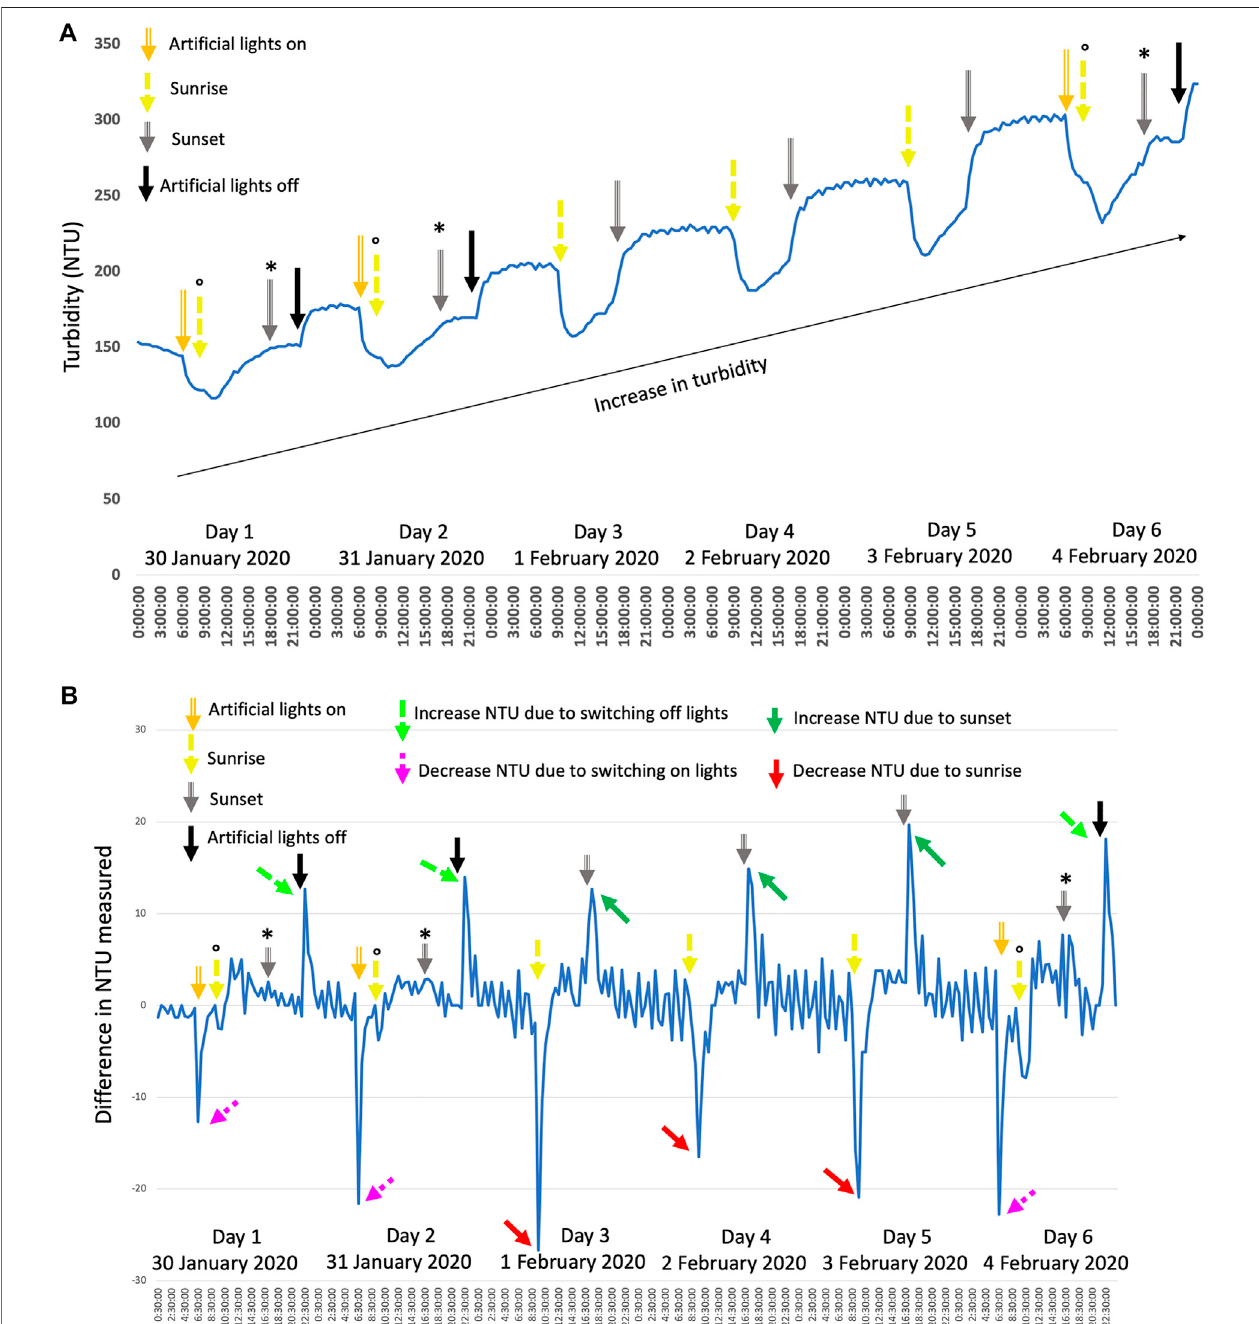
FIGURE 5 | (A) shows the typical growth pattern of C. typhlos observed over several days. A representative period during one of the winter periods is shown here witharti fi cial lights being used toextend theday. Arti fi cial lights were kept on between6.30 – 10.30 and 15.30 – 22.00,although slight variances were possible depending on the real sunset and sunrise times ofthe speci fi c days. (B) shows the difference in the NTU value calculated for every 30 min (NTUx+30min — NTUx) plotted over time. Arrows indicate speci fi c time points or substantial increases/decreases. The symbol ° denotes the arti fi cial light switching off at sunrise, while the symbol * denotes the arti fi cial lights switching on at sunset. See text for more